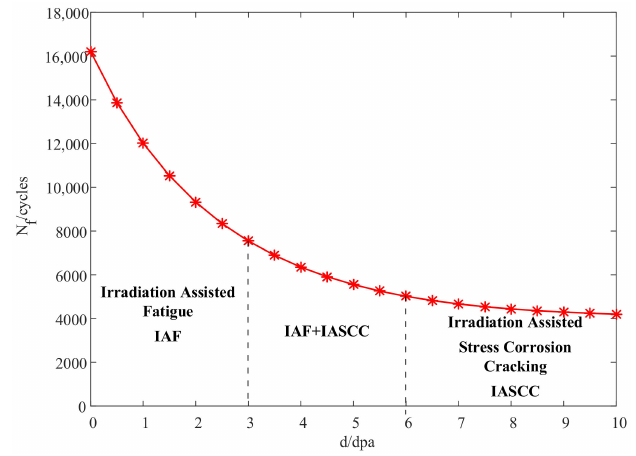
Figure 6. Fatigue life varying with neutron